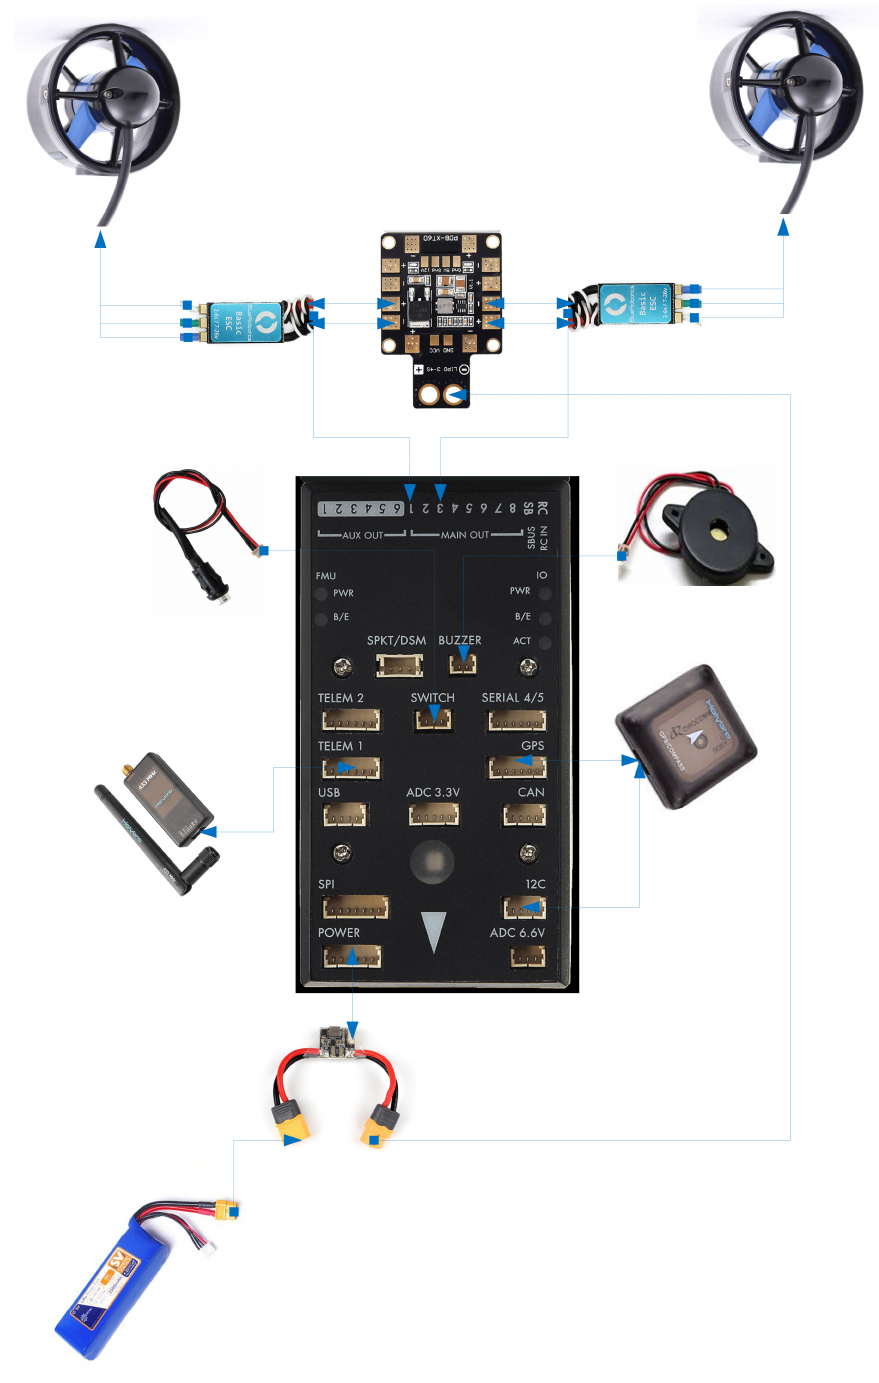
Figure 4. Wiring diagram for the USV